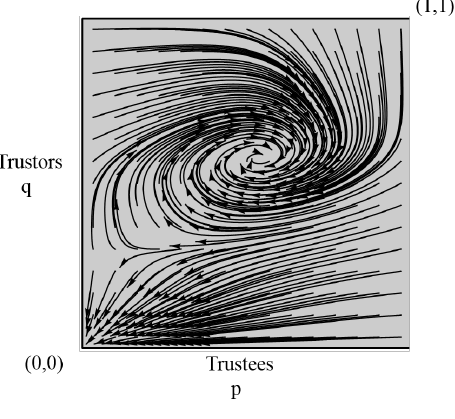
Figure 4. Logit dynamics of the game under moral codes ( η = 0 . 1 , e = 0 . 24 , v = 2 c = 1